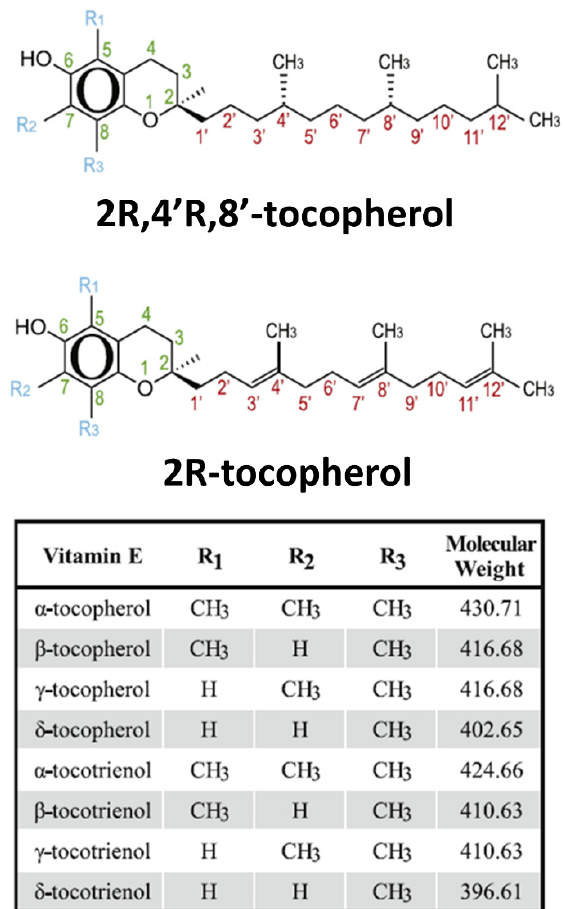
Figure 1. Molecular structure of tocotrienols adapted and slightly modified from Peh et al. (2016) [8]. Reprinted/adapted with permission from [8].